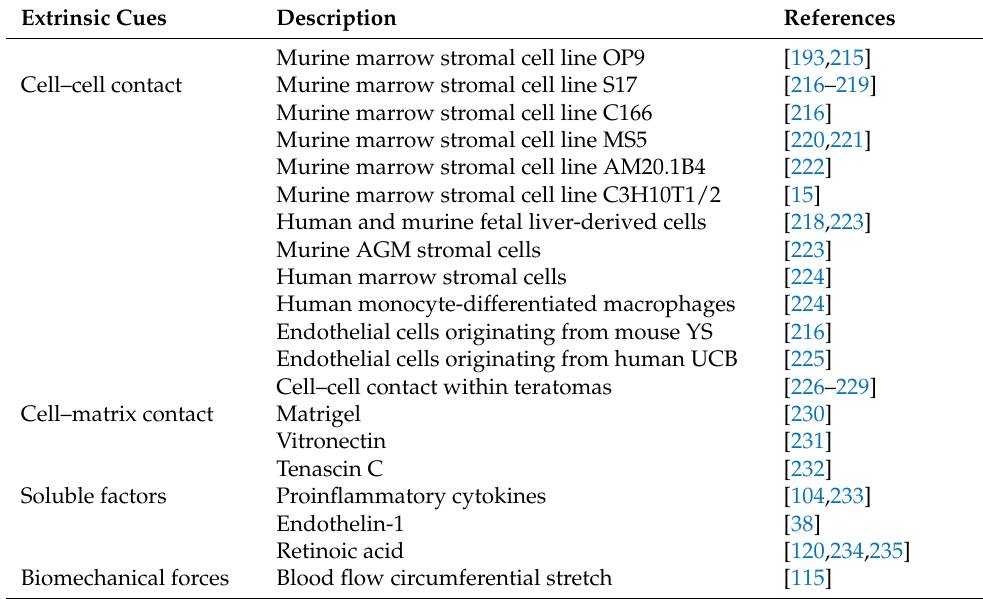
Table 2. Extrinsic cues for de novo generation of HSCs from human